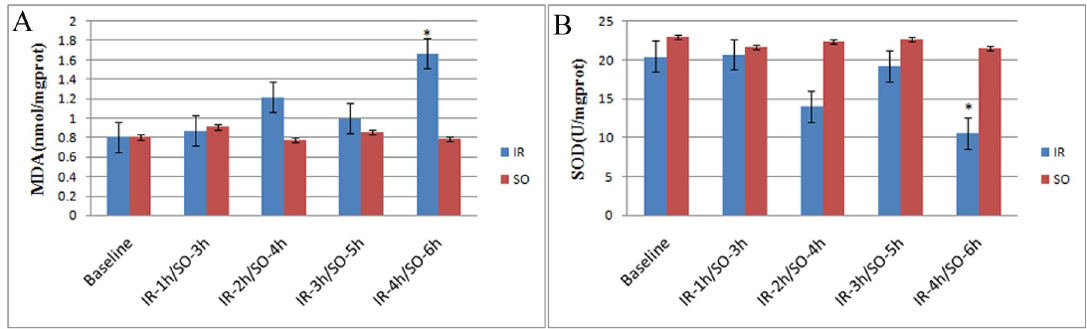
Fig 3. The variation of Malondialdehyde (MDA) and Superoxide dismutase (SOD) originated from intestinal mucosa homogenate. An increasing trend in MDA levels(A) and a decreasing trend in SOD (B) activity with the increase in IR time can be observed; however, some regression is observed in the IR-3h group. * p < 0.01 vs. corresponding SO groups.)